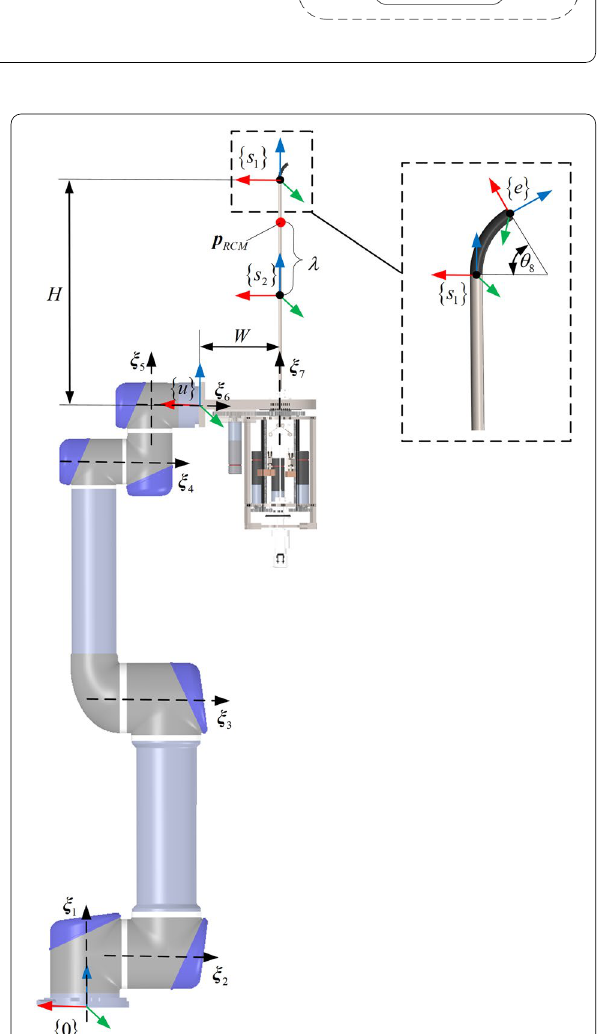
Figure 7 Constraint of RCM and coordinate